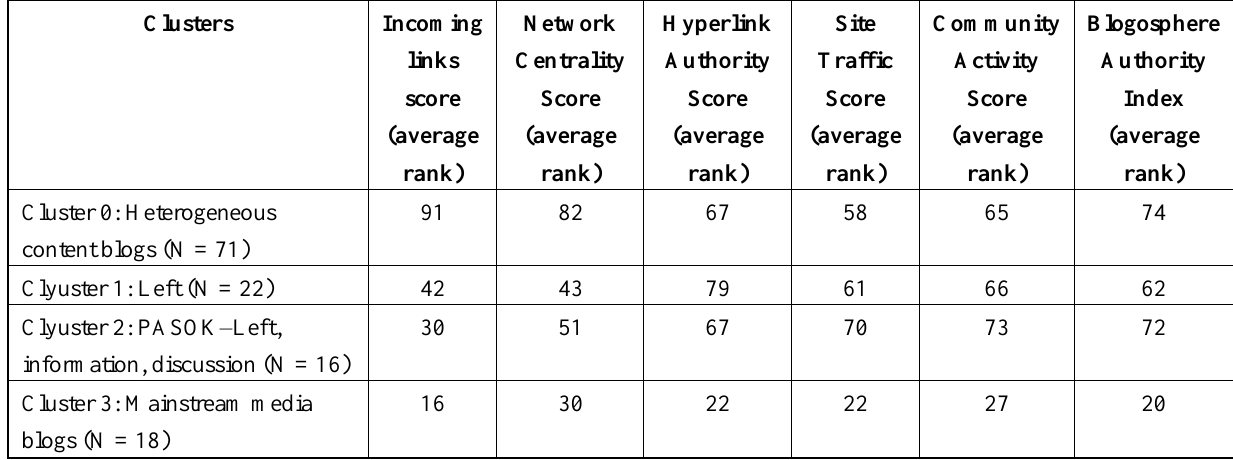
Table 4. Centrality and Authority Scores of the clusters.